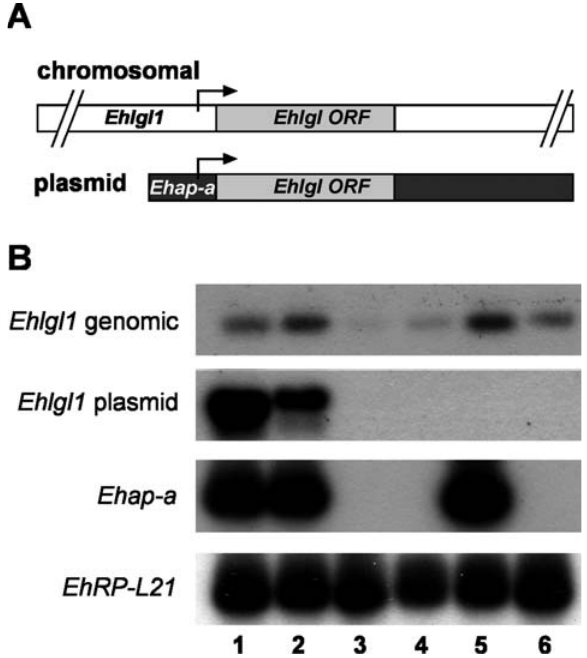
Figure 3. Identification of the Source of Ehlgl1 Transcripts (A) Diagrams of the location of the two different sense primers used to differentiate between the two types of Ehlgl1 transcripts (genomic and plasmid-derived). (B) RT-PCR analysis of different transfectants. Isolated RNA was subjected to reverse transcription and PCR for several types of transcripts: genomic